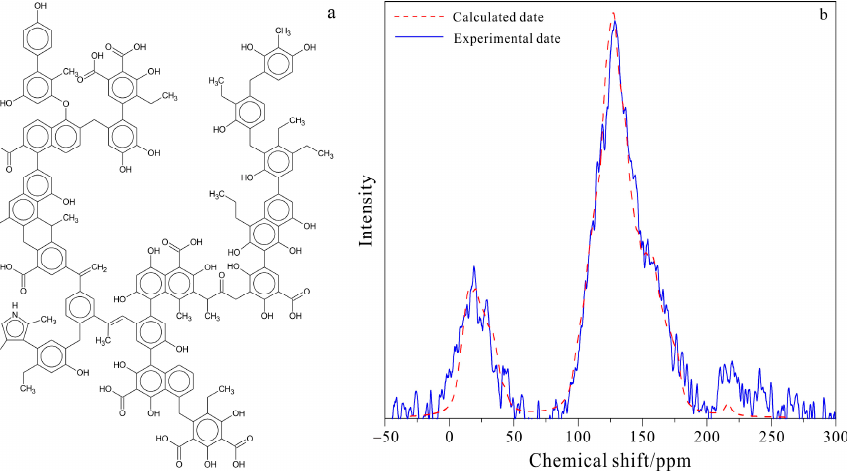
Figure 5. ( a ) Two-dimensional molecular structure of the FK–3 coal; ( b ) comparison of experimental data and calculated data.